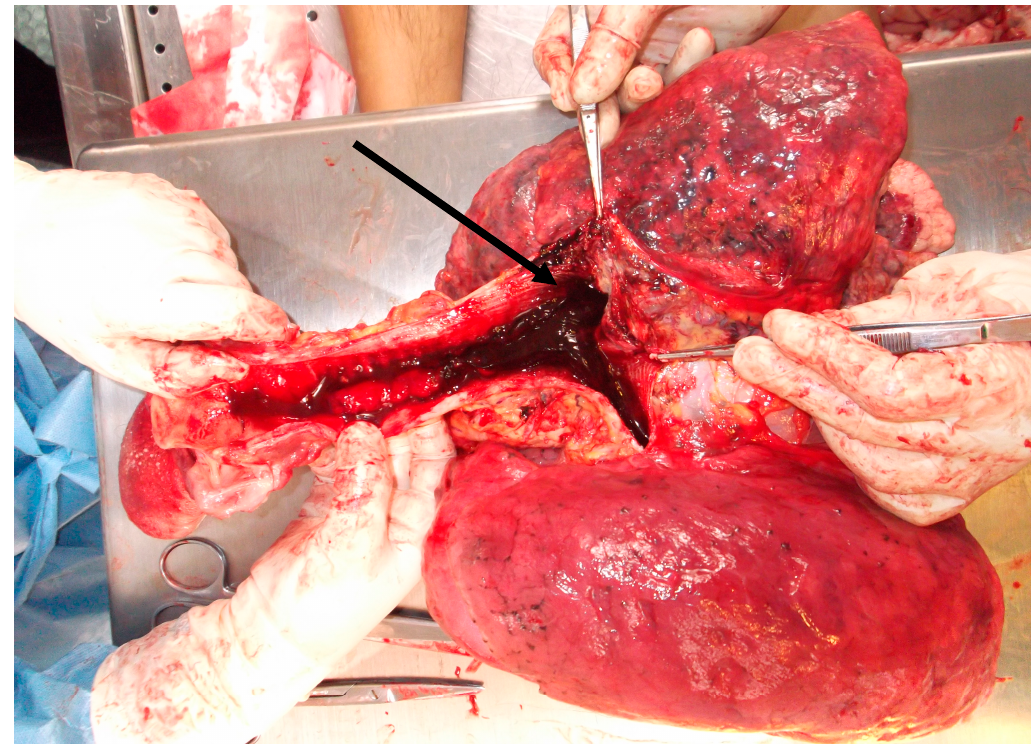
Figure 2. Posterior view. The trachea with its bifurcations entirely occupied by blood material both in the larger diameter ducts and in the smaller caliber airways (black arrow).